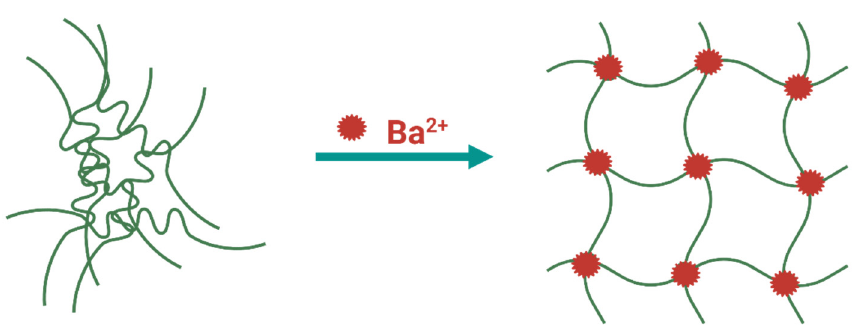
Figure 2. Schematic representation of barium crosslinking. Figure created with BioRender.com.